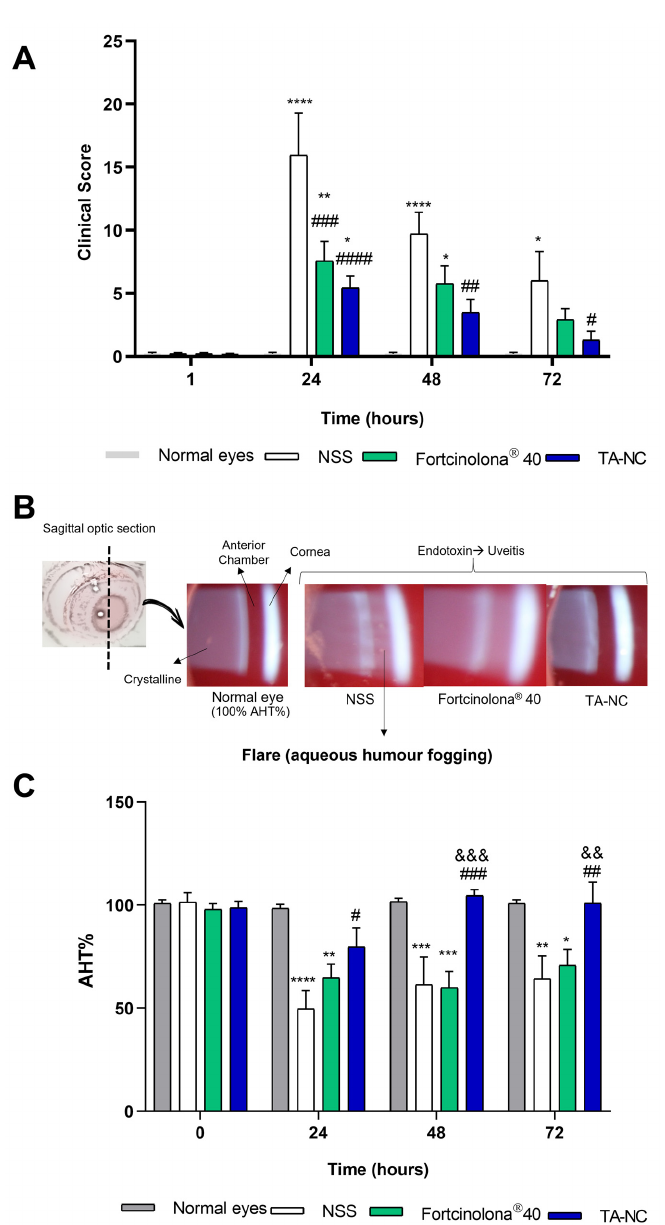
Figure 11. Evaluation of therapeutic efficacy of TA-NC. ( A ) Clinical inflammation score of rabbits treated with normal saline solution (NSS), TA-NC and Fortcinolona ® 40 after 24 h, 48 h and 72 h of EUI model in comparison to normal animals. ( B ) Representative photographs taken with slit lamp of the anterior chamber of normal eye and eyes exposed to EIU in vivo model (induced by LPS) treated with normal saline solution (NSS), TA-NC and Fortcinolona ® 40 after 24 h, 48 h and 72 h of